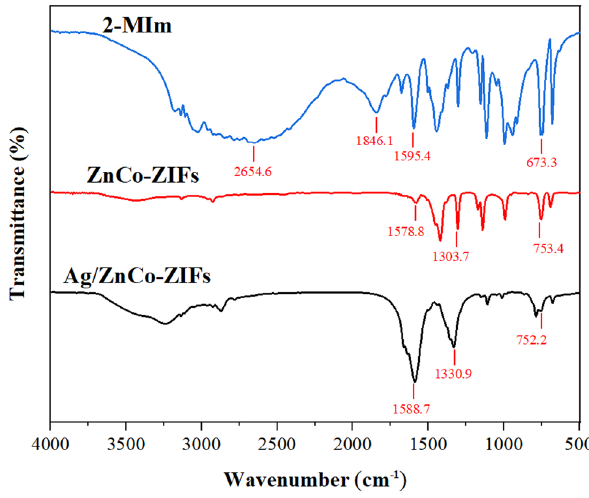
Figure A5: TGA analysis of ZnCo - ZIFs and Ag/ZnCo -